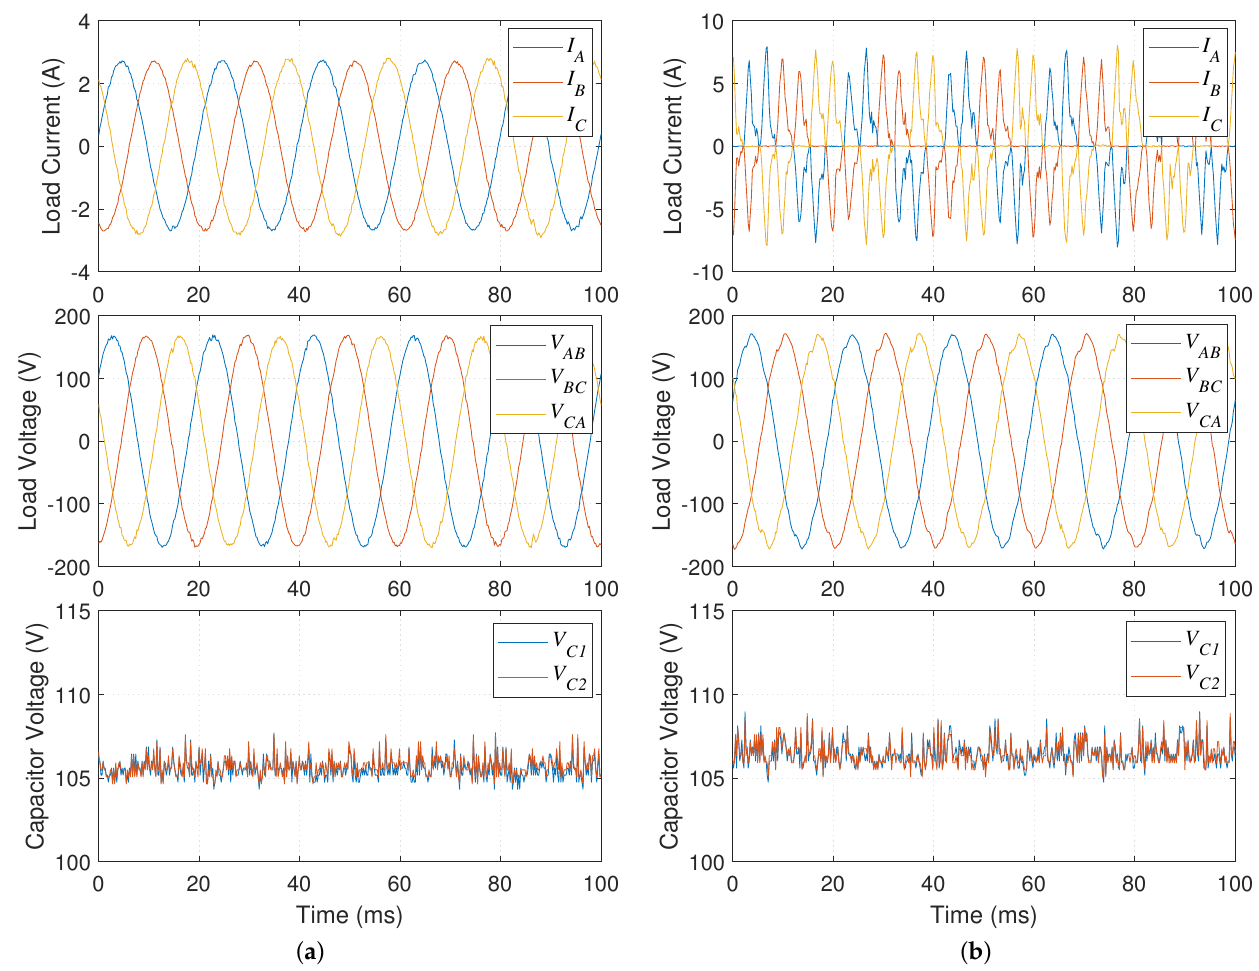
Figure 31. UPS Inverter prototype experimental waveforms with linear and non-linear loads, acquired with the Zedboard, using Simulink External mode. ( a ) Linear Load. ( b ) Non-Linear